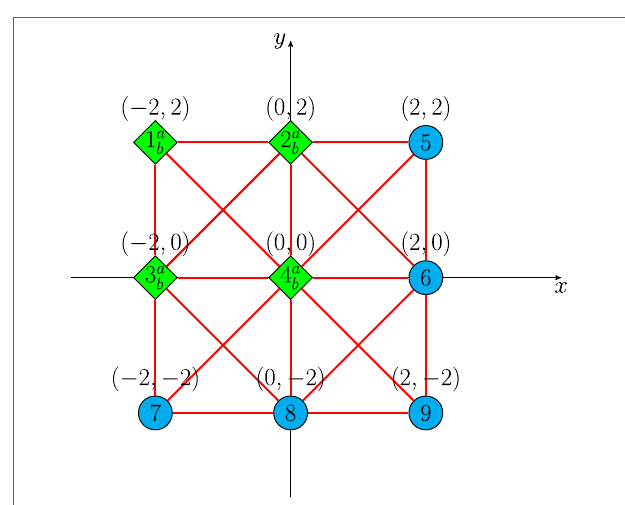
FIGURE 18 | Communication graph of the active-passive sensor network in Example 5 with 13 nodes (lines denote communication links, circles denote normal nodes, and diamond denotes overlapped